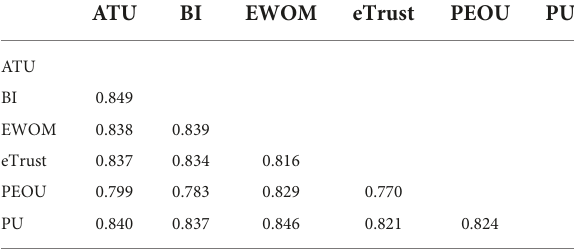
TABLE 4 The heterotrait–monotrait ratio of correlations